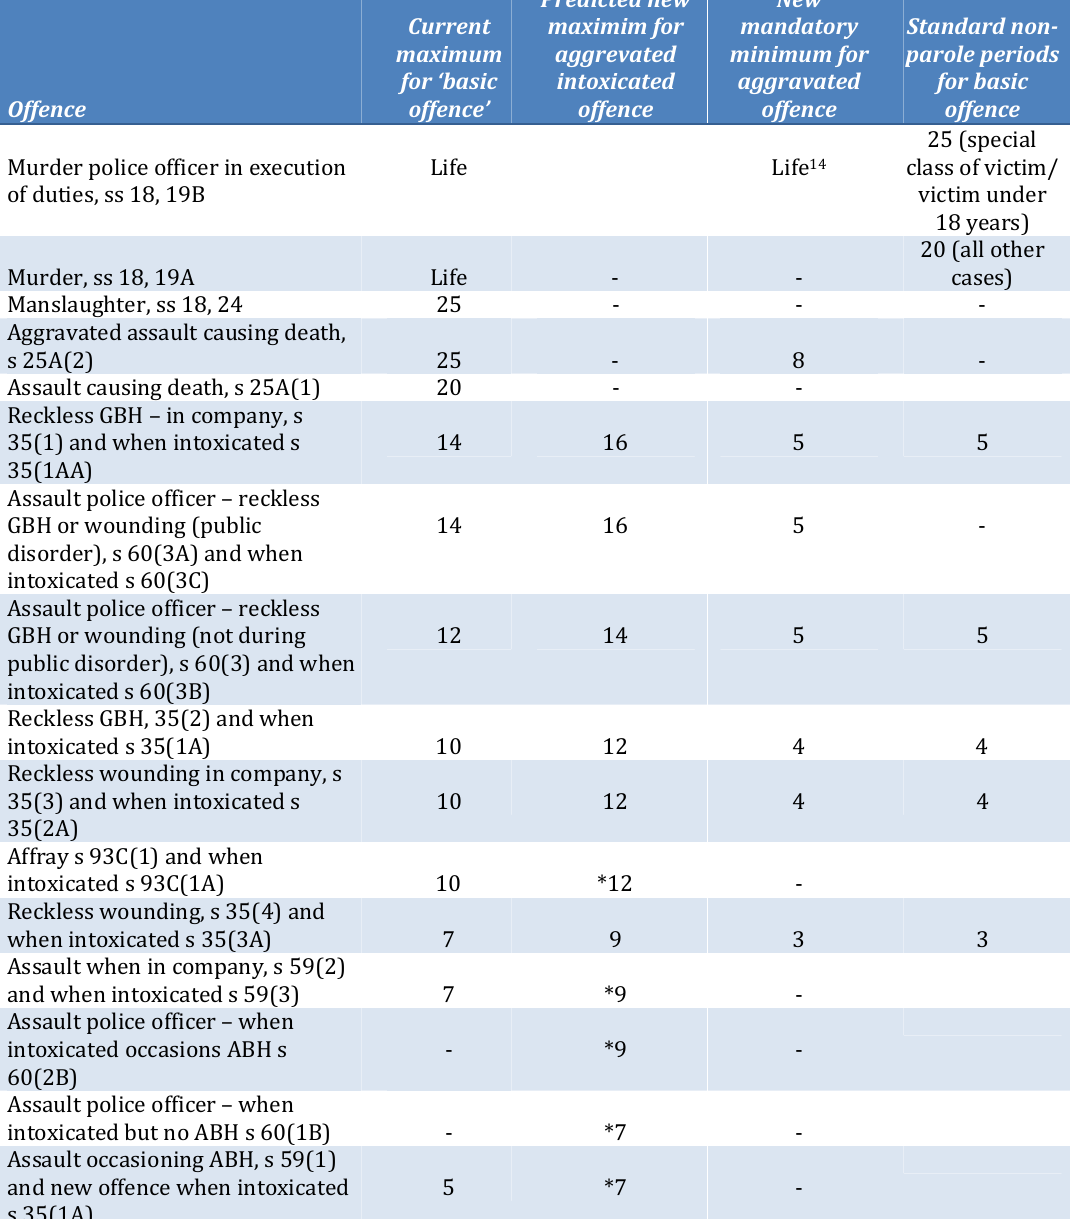
Table 1: Comparison of basic and aggravated offences Offence